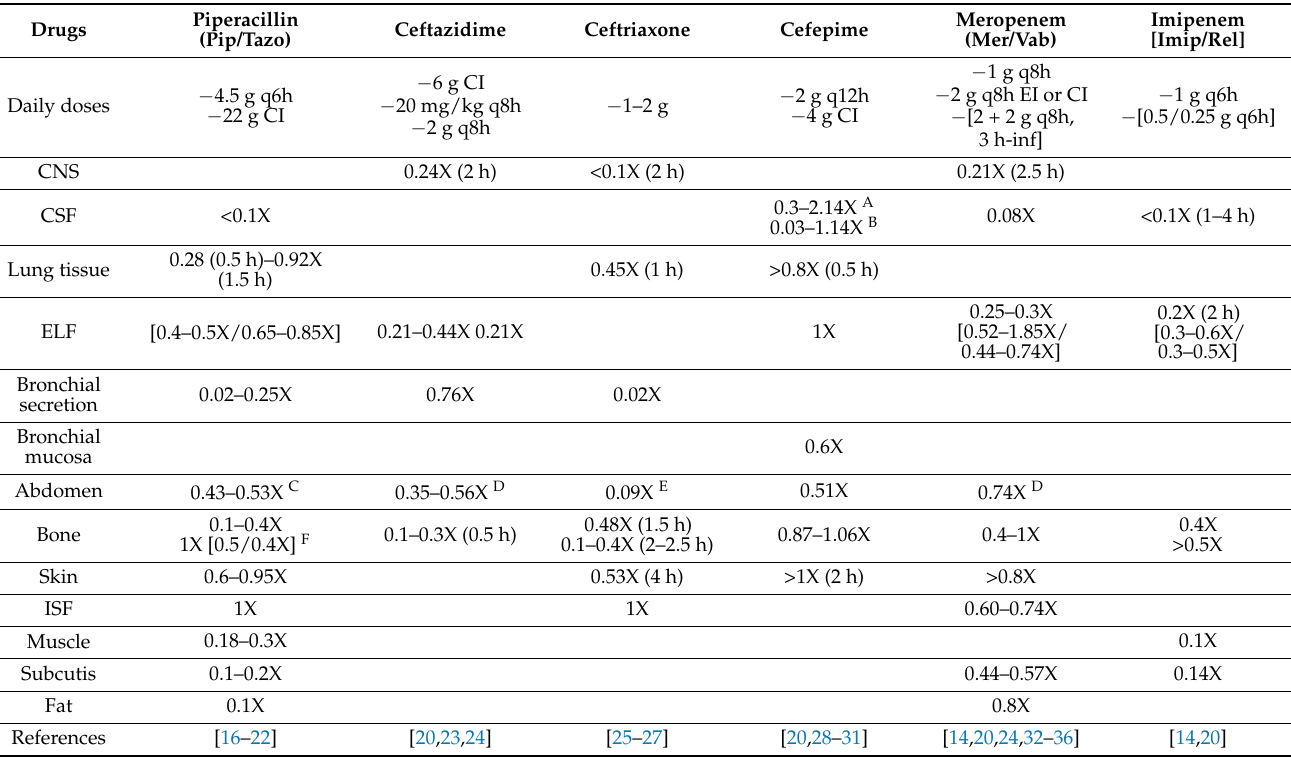
Table 1. Tissue/plasma ratio values for some beta-lactams. For beta-lactams/beta-lactamase inhibitor combinations, ratio values are within square brackets. The different daily doses administered to ICU patients are listed in the